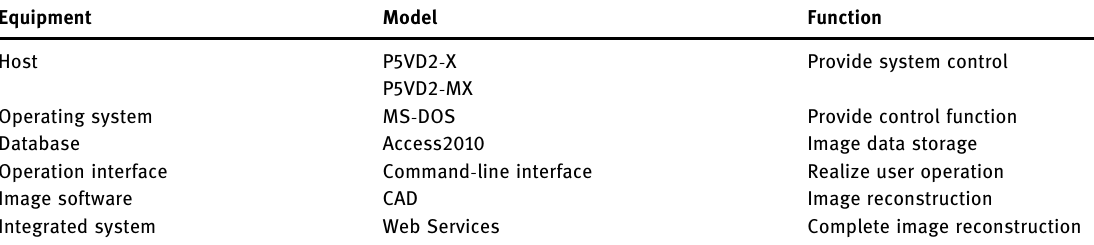
Table 2: Experimental equipment parameters